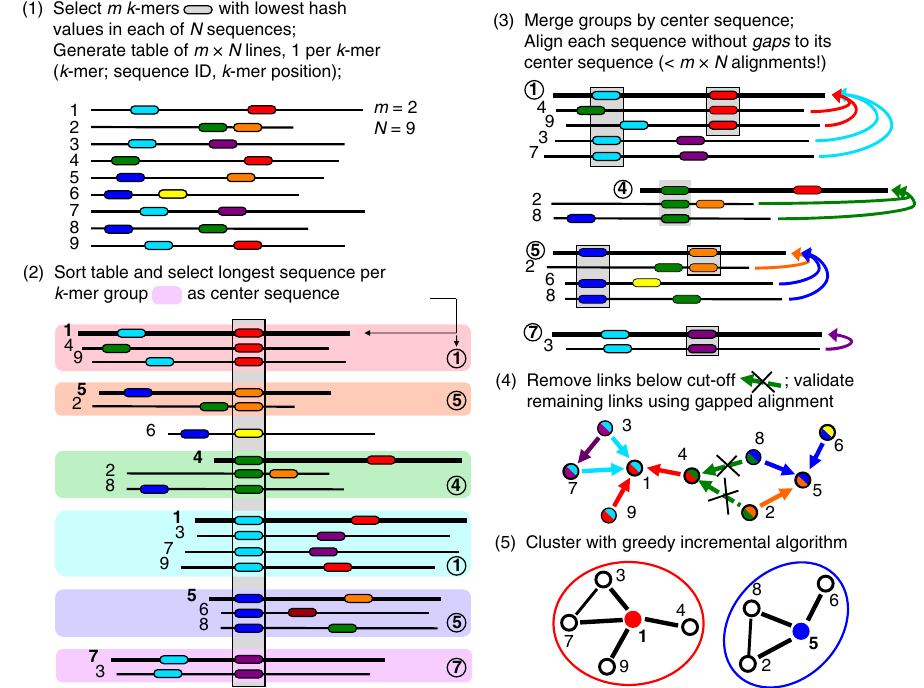
Fig. 5 Linear-time clustering algorithm. Steps 1 and 2 fi nd exact k -mer matches between the N input sequences that are extended in step 3 and 4. (1) Linclust selects in each sequence the m (default: 20) k -mers with the lowest hash function values, as this tends to select the same k -mers across homologous sequences. It uses a reduced alphabet of 13 letters for the k -mers and sets k between 10 and 14 depending on the sequence set size and the sequence identity threshold. It generates a table in which each of the mN lines consists of the k -mer, the sequence identi fi er, and the position of the k -mer in the sequence. (2) Linclust sorts the table by k -mer in quasi-linear time, which identi fi es groups of sequences sharing the same k -mer (large shaded boxes). For each k -mer group, it selects the longest sequence as center. It thereby tends to select the same sequences as center among groups sharing sequences. (3) It merges k -mer groups with the same center sequence together ( 1 : red + cyan and 5 : orange + blue) and compares each group member to the center sequence in two steps: by global Hamming distance and by gapless local alignment extending the k -mer match. (4) Sequences above a score cut-off in step 3 are aligned to their center sequence using gapped local sequence alignment. Sequence pairs that satisfy the clustering criteria (e.g., on the E sequence has an edge to its cluster ’ s representative sequence. Note that the number of sequence pairs compared in steps 3 and 4 is less than mN ,